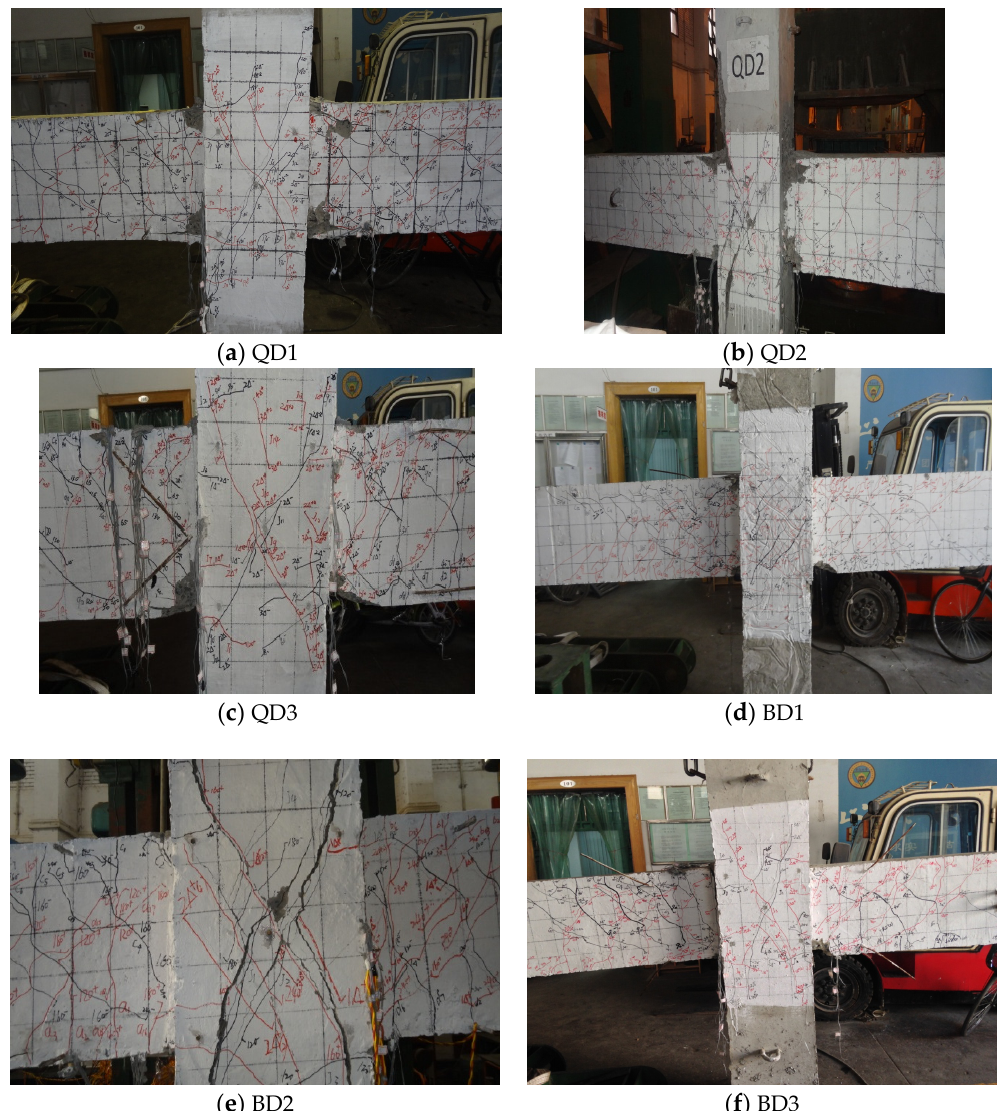
Figure 5. Failure modes of the six specimens. ( a ) QD1; ( b )QD2; ( c ) QD3; ( d ) BD1; ( e ) BD2; ( f ) BD3.